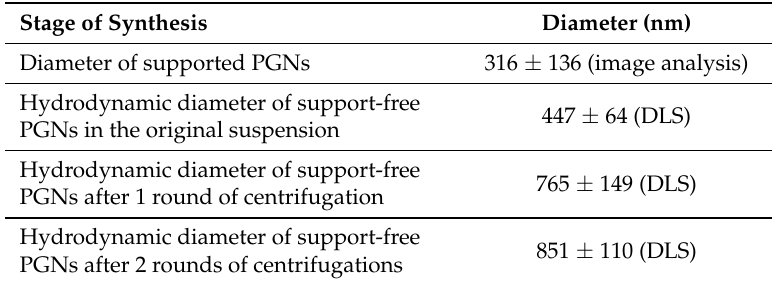
Table 2. Mean particle size of porous gold nanoparticles (PGNs) at the different stages of synthesis. The size distribution of the initial supported particles was calculated by the analysis of their SEM (SE) images. The suspensions of support-free PGNs detached from CaF 2 substrate were analyzed by DLS. Standard deviations are calculated from triplicate measurements. Representative particle size distribution curves measured in the suspensions of PGNs by DLS are given in Figure 4.